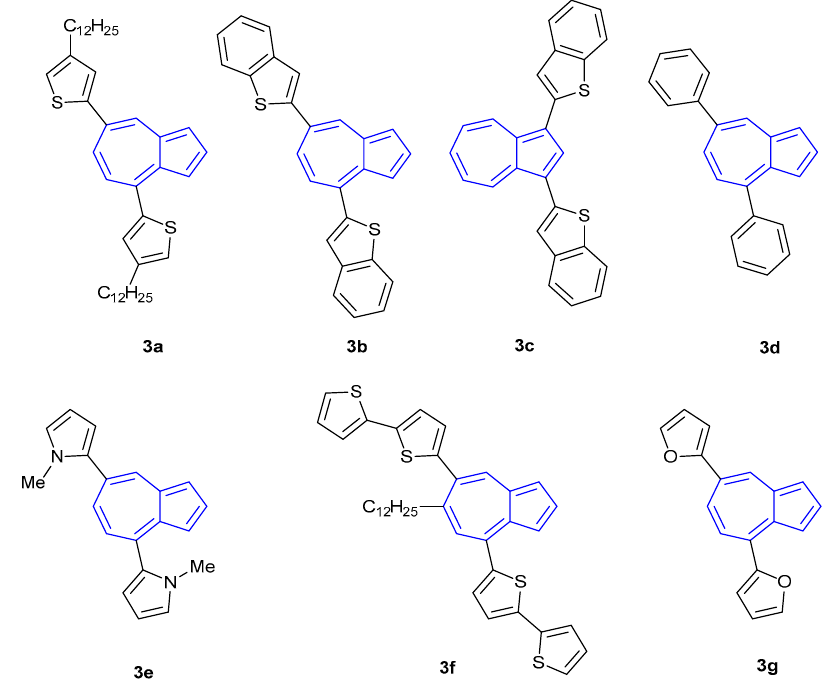
Figure 3. Azulene-thiophene oligomer synthesised by Hawker et al. [47,48].